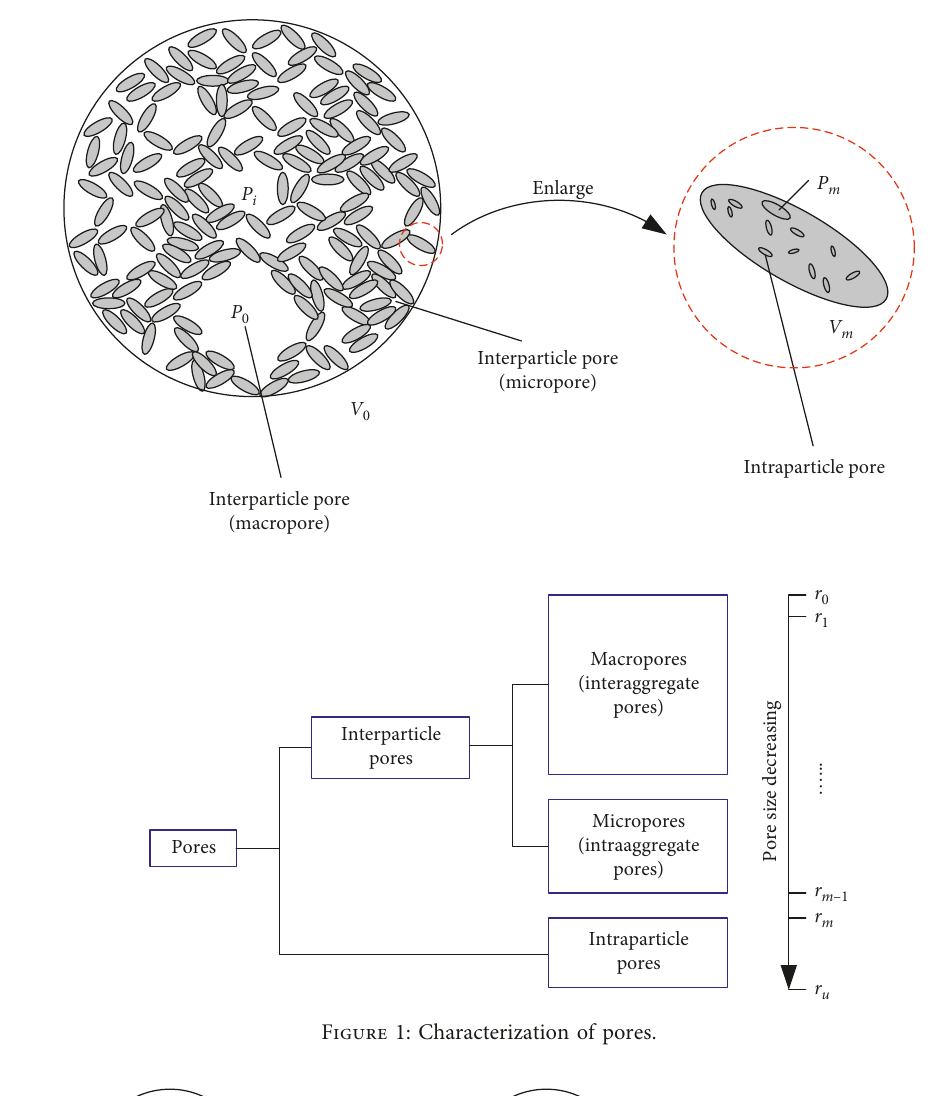
Figure 1: Characterization of pores.